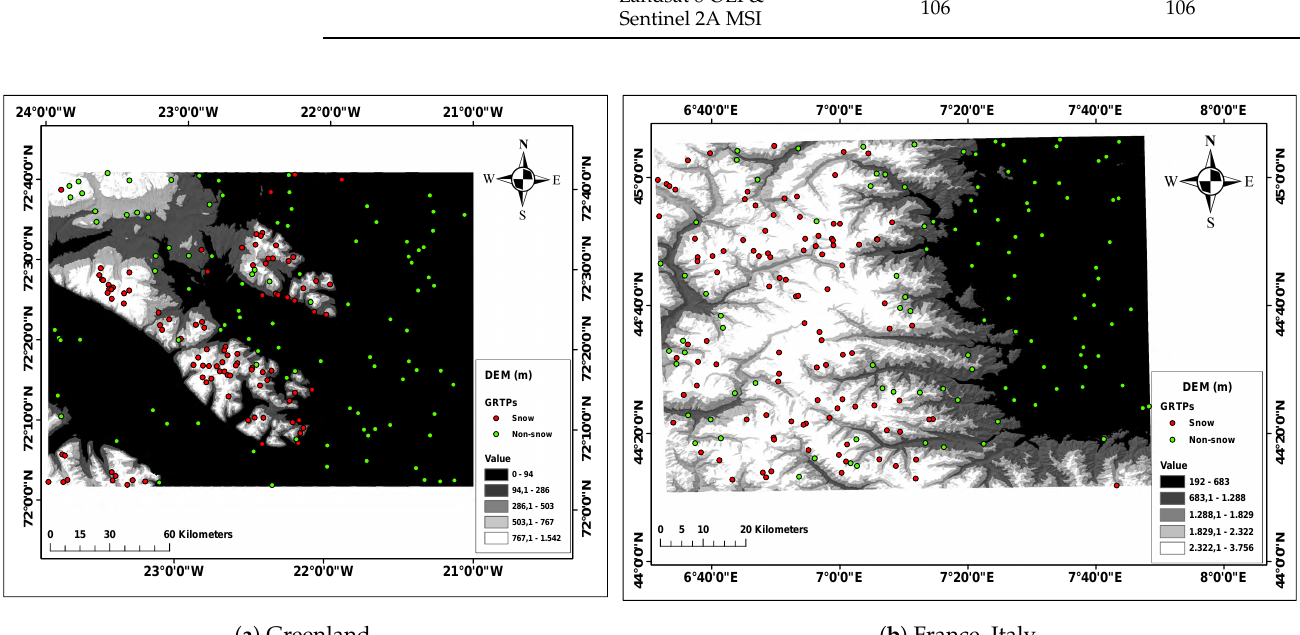
Figure 12. Distribution of the Ground Reference Test Pixels (GRTPs) over the Digital Elevation Model (DEM) images registered by the Advanced Spaceborne Thermal Emission and Reflection Radiometer (ASTER) of ( a ) the France–Italy and ( b ) the Greenland area. The DEM was used to verify the elevation ranges of the areas. The size of the GRTPs were magnified to visualize the distribution. Moreover, the three red dots on the black area of ( a ) are snow over islands and can be visualized in the reference images of Figure